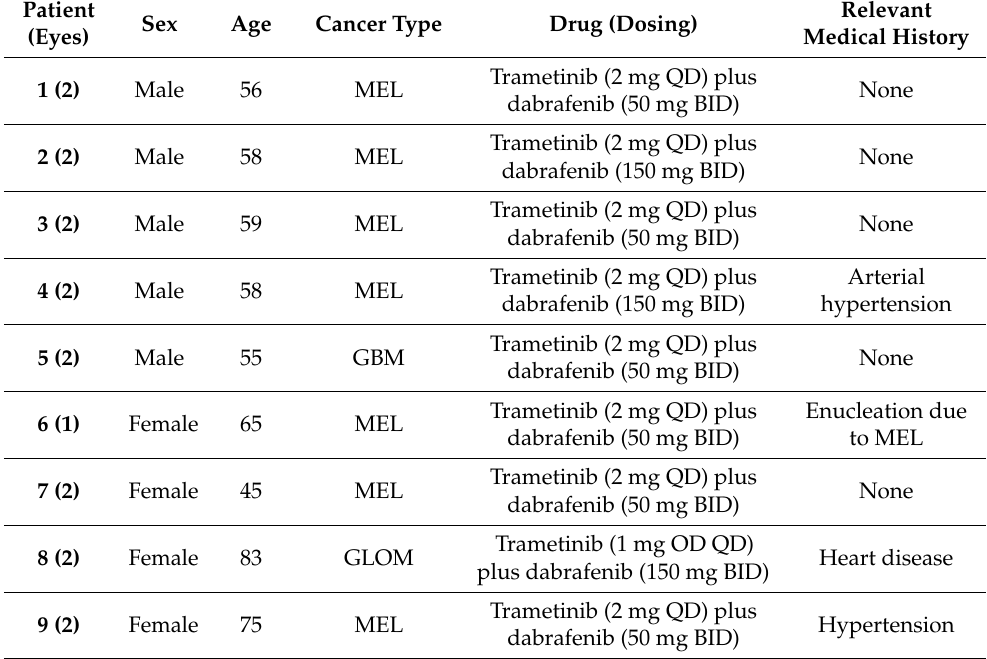
Table 1. Clinical baseline